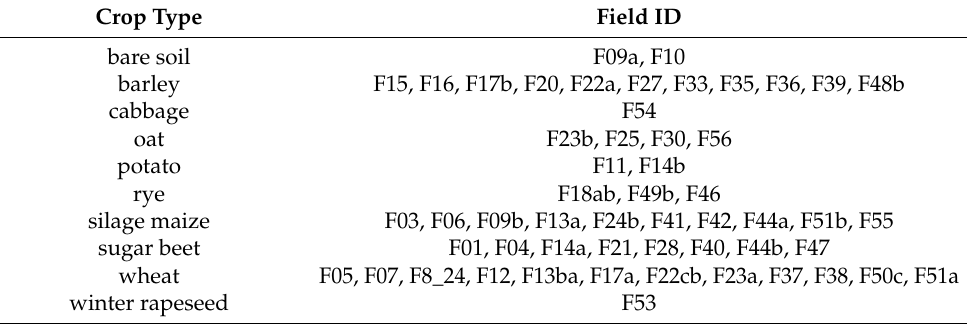
Figure 1. Map of the Selhausen test site and airborne flight tracks (left) as well as the individual crop types and field IDs (right). Table 1. Overview of crop types and field IDs for the Selhausen test